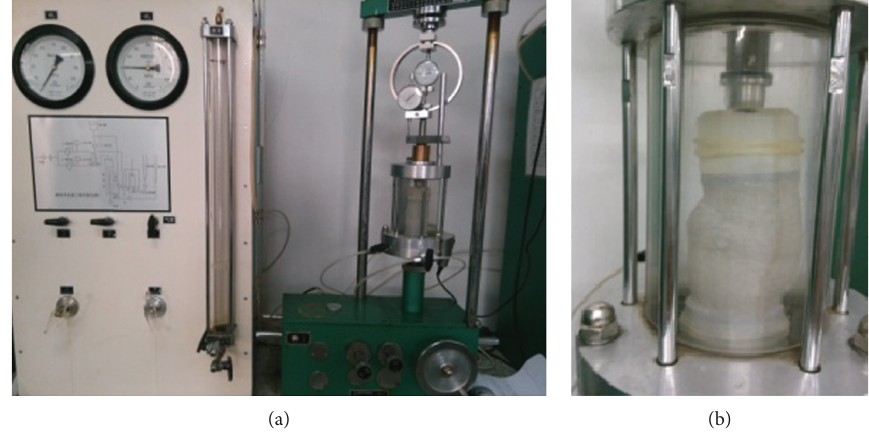
Figure 4: The triaxial compression test.